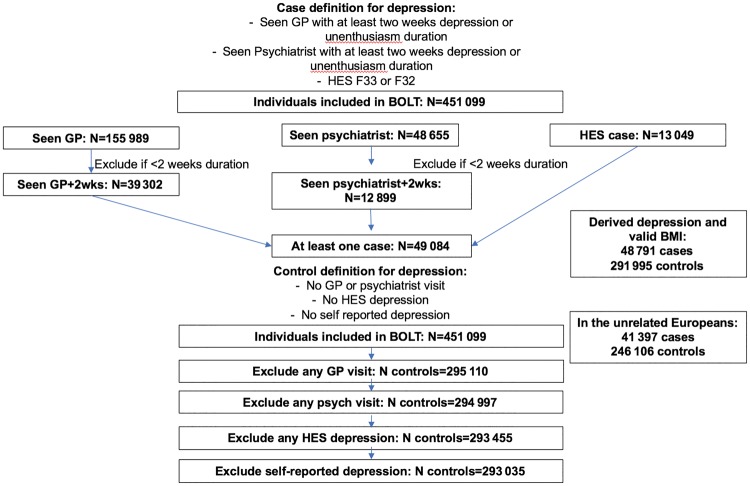
Flow chart explaining the derivation of depression cases and controls in the UK Biobank.